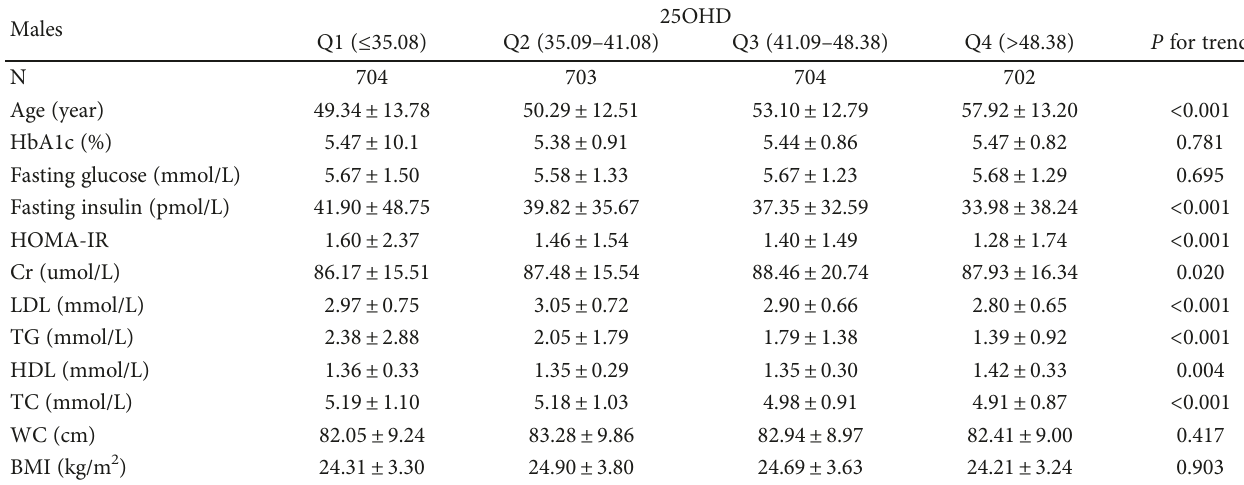
Table 1: Comparison between di ff erent 25(OH)D subgroups in